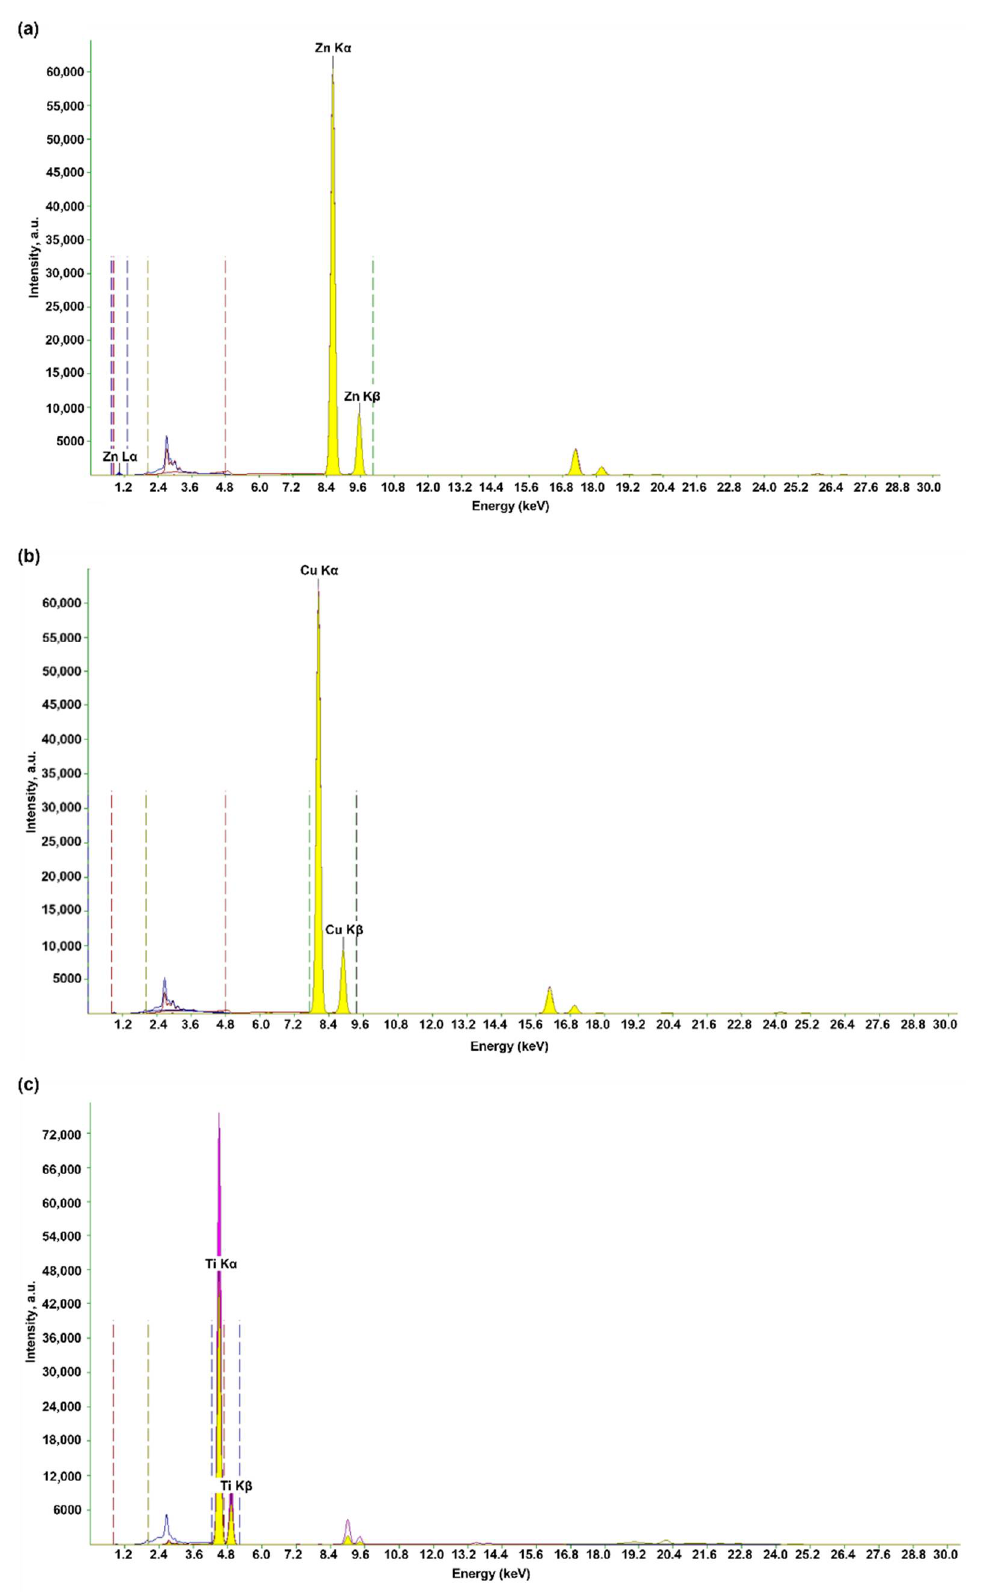
Figure 2. The obtained EDXRF spectra for the analyzed oxides: zinc oxide ( a ); copper(II) oxide ( b ); titanium(IV) oxide ( c